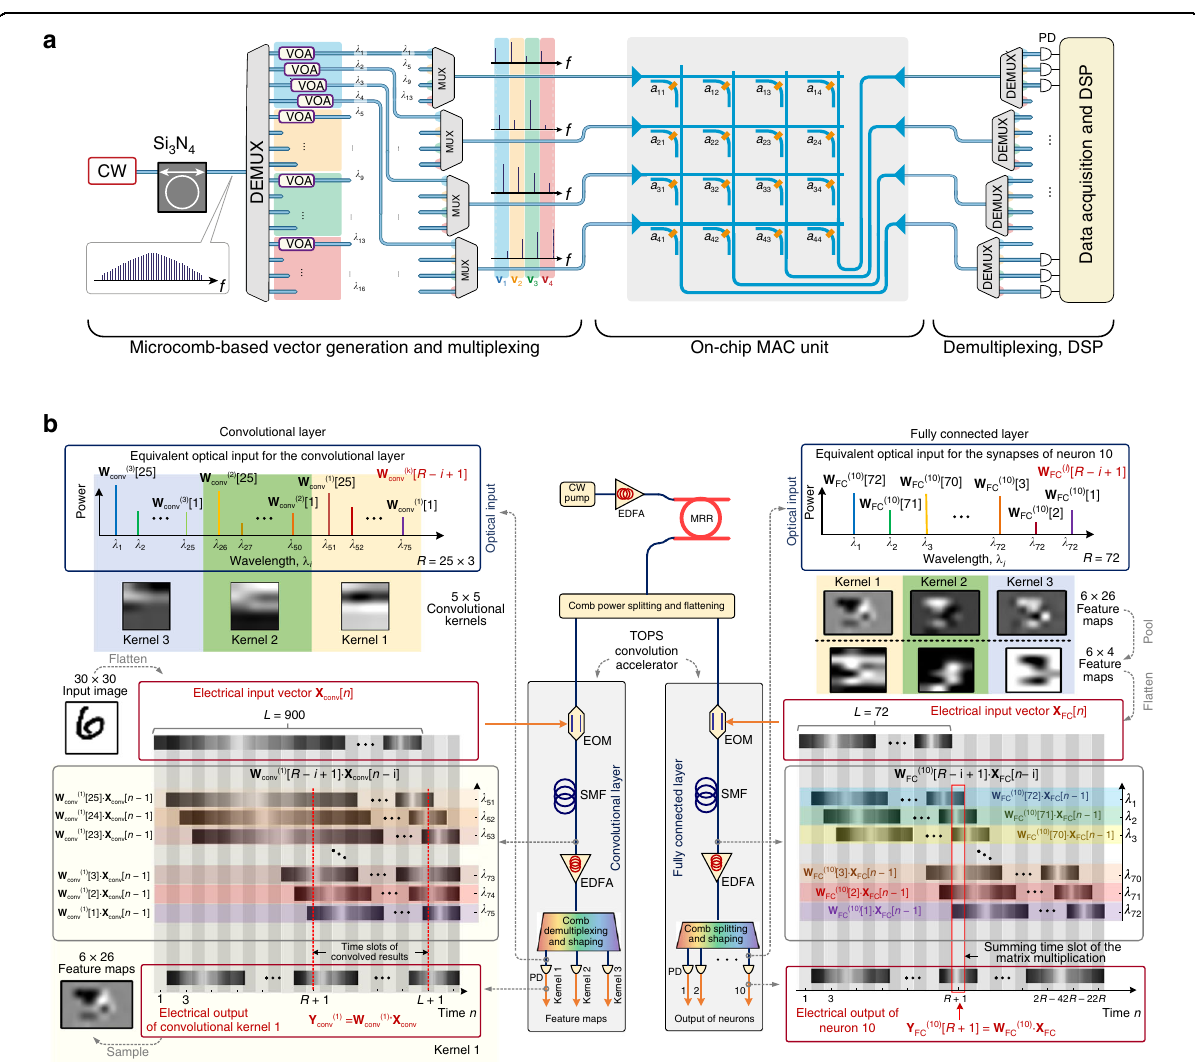
Fig. 13 WDM-MVMs for large-scale parallel computing in ONNs. a Parallel convolutional processer chip 90 . b Photonic convolutional accelerator 16 . a Reprinted from ref. 90 with permission from Springer Nature: Nature. b Reprinted from ref. 16 with permission from Springer Nature: